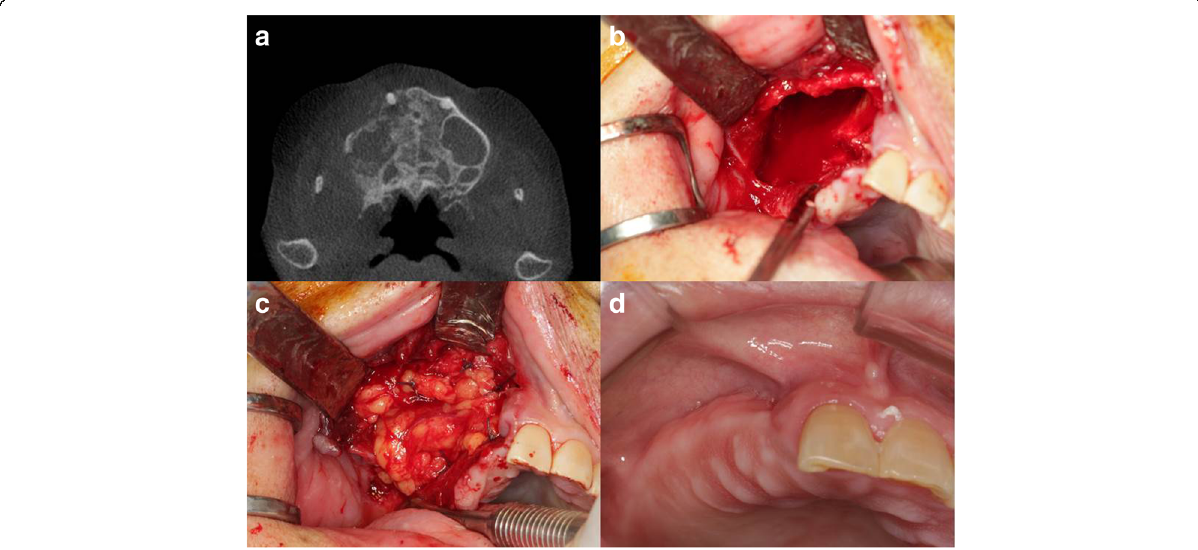
Fig. 2 Case 2. a CT showed destruction of the right maxillary alveolar bone and right maxillary sinusitis. b Intraoperative view showed large oroantral